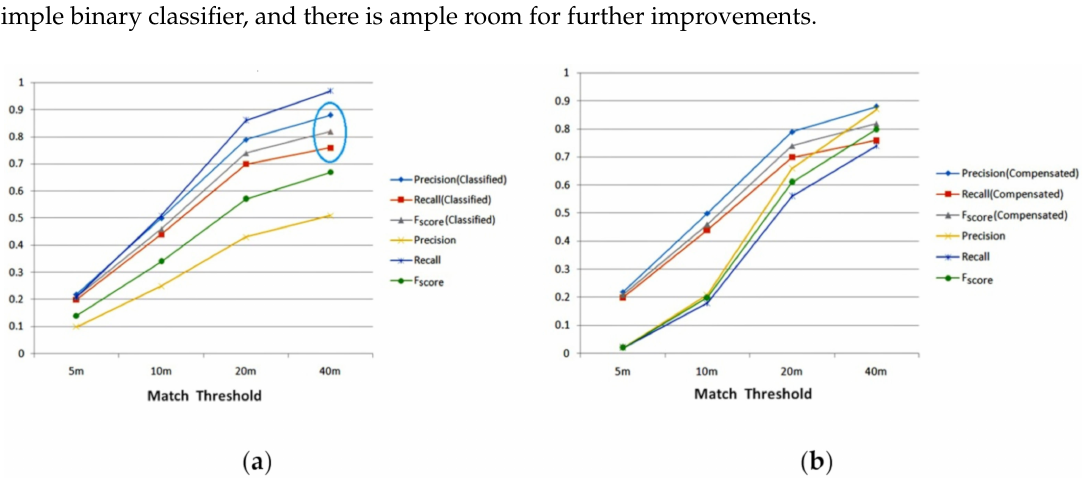
Figure 11. Detection precision, recall, and F score . ( a ) comparing detection result with non-classified; ( b ) comparing detection result with